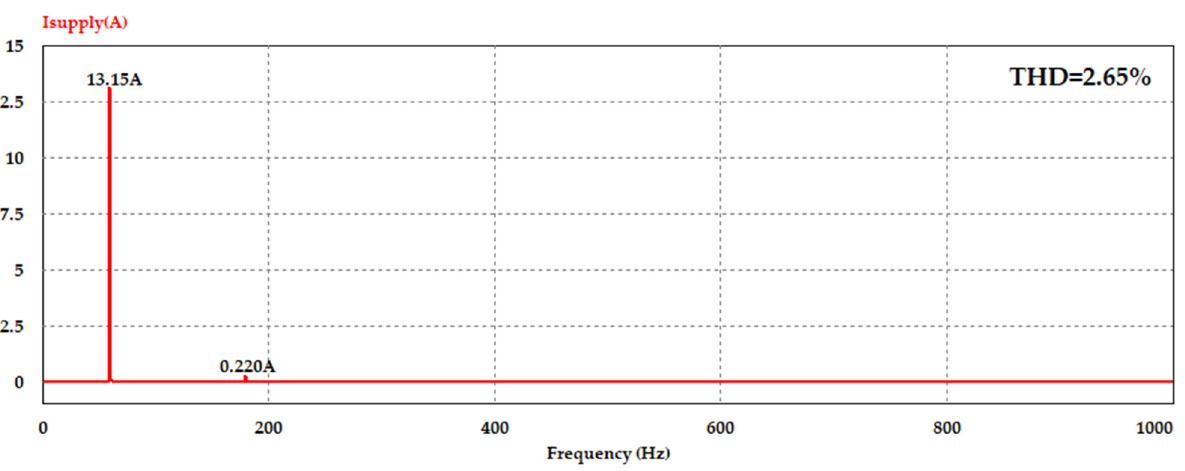
Figure 21. Supply current frequency spectrum for the conventional CCM PFC.